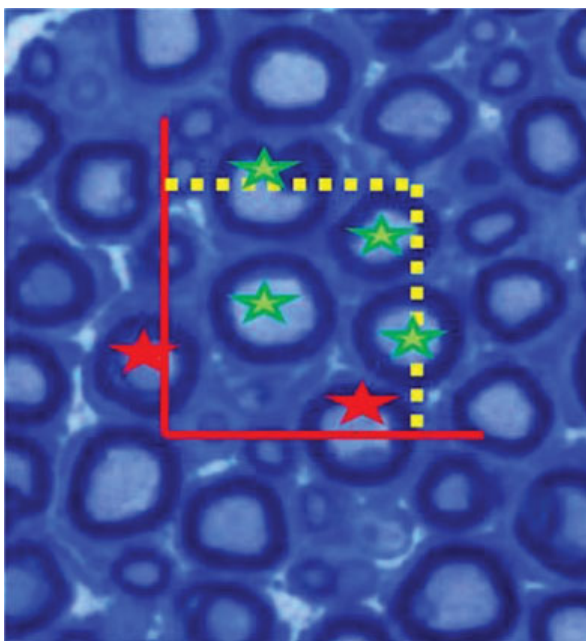
Fig. 4 Unbiased counting frame method with a square sample area. The nerve pro fi les marked with green stars in panel A would be included in the counts but not the pro fi les marked with red stars